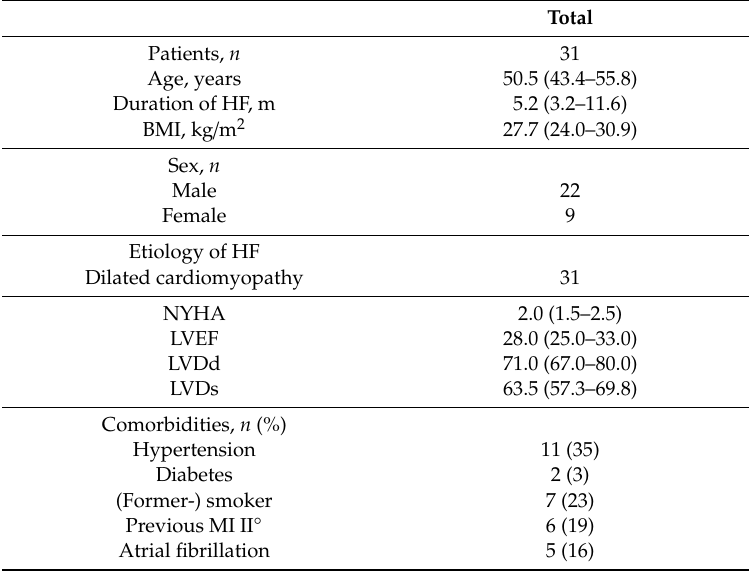
Table 1. Baseline characteristics before immunoadsorption